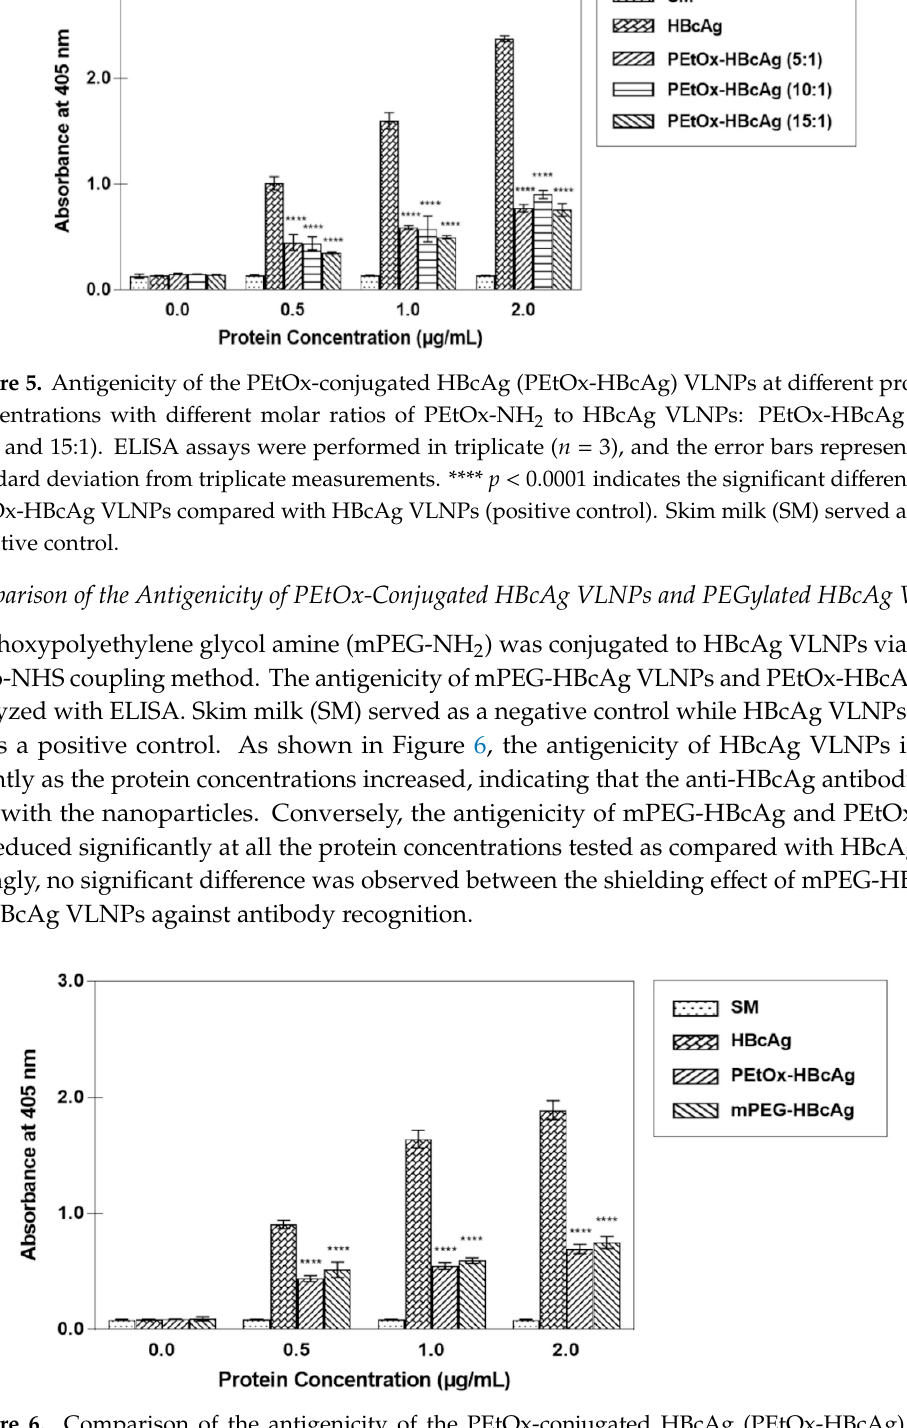
Figure 6. Comparison of the antigenicity of the PEtOx-conjugated HBcAg (PEtOx-HBcAg) and methoxypolyethylene glycol amine (mPEG)-conjugated HBcAg (mPEG-HBcAg) VLNPs at different protein concentrations. ELISA assay was performed in triplicate ( n = 3), and the error bars represent the standard deviation from triplicate measurements. **** p < 0.0001 indicates the significant difference of PEtOx-HBcAg VLNPs and mPEG-HBcAg VLNPs compared with HBcAg VLNPs (positive control). Skim milk (SM) served as the negative control.